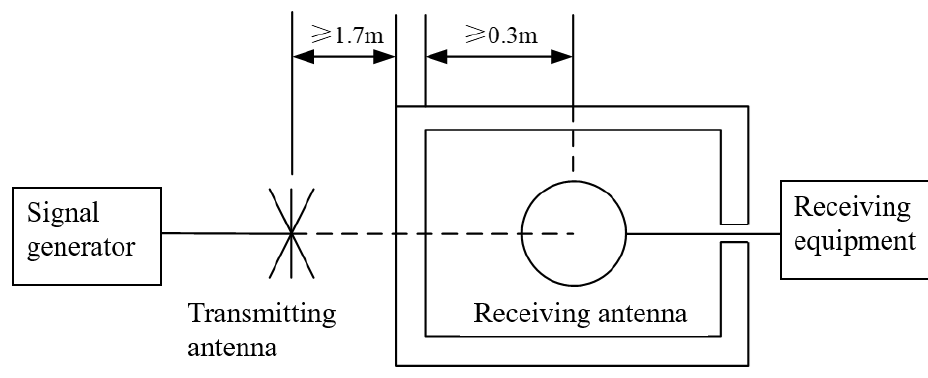
Figure 14. Reference test placement.